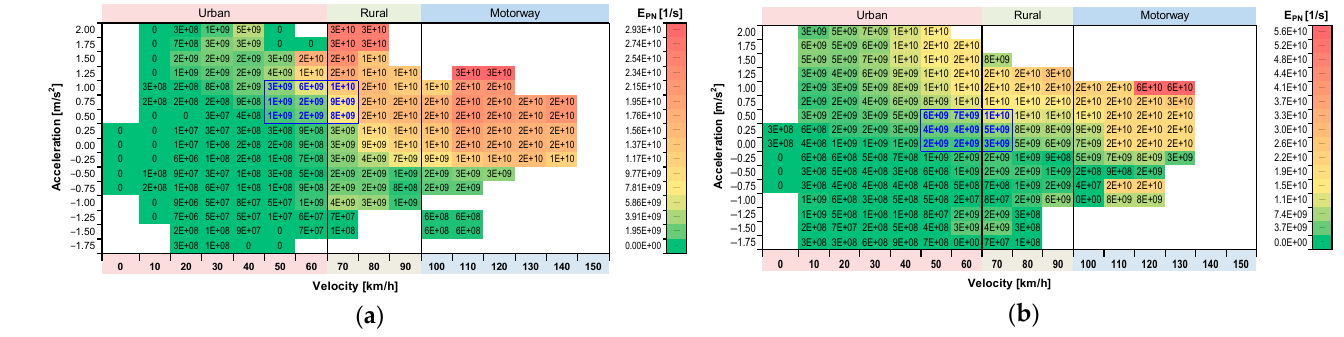
Figure 34. Particle number rate (E PN ) in the RDE test for: ( a ) plug-in; ( b ) HEV. By using the MAW (Mowing Average Window) algorithm and knowing the instan- neous on-road emissions of CO 2 , CO, NO x , and PN, the on-road emissions of each exhaust emission compound can be determined. The final result can be obtained for each test phase (urban, rural, motorway) and for the entire RDE test. Using this procedure, the on-road emissions of the various compounds were determined for the plug-in vehicle and the HEV. Comparing the on-road emissions of carbon dioxide (Figure 35a), the plug-in vehicle emits almost 70% less carbon dioxide in the urban phase and 40% less in the rural phase. This is the result of combining the energy from the combustion engine and the electric emissions of the entire RDE test, where the plug-in vehicle recorded only a 10% lower motor. In the motorway phase, the differences are negligible, as both vehicles use an internal value than the HEV vehicle. This is mainly due to the lack of a particulate filter in these vehicles, which does not prevent them from meeting the permissible limits in the RDE test combustion engine. The total on-road CO 2 emissions in the RDE test are a weighted average (increasing the limit by a value of 1.5, which translates into a permissible level of 1.5 × of the three phases; thus, the final emissions are about 30% less for the plug-in vehicle compared to the HEV.